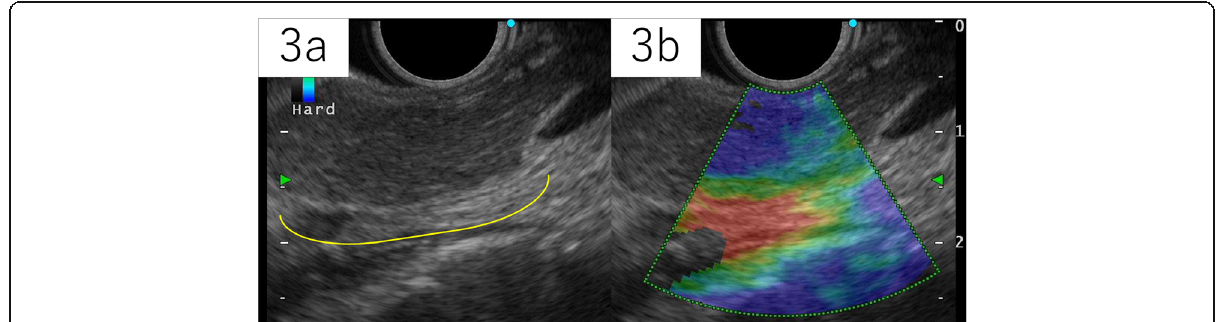
Fig. 3 Endoscopic ultrasonography (EUS) depicted well-demarcated mass (indicated with arched line) with inside mosaic pattern ( 3a ), and the mass was described harder than the parenchyma of the pancreas by elastography ( 3b